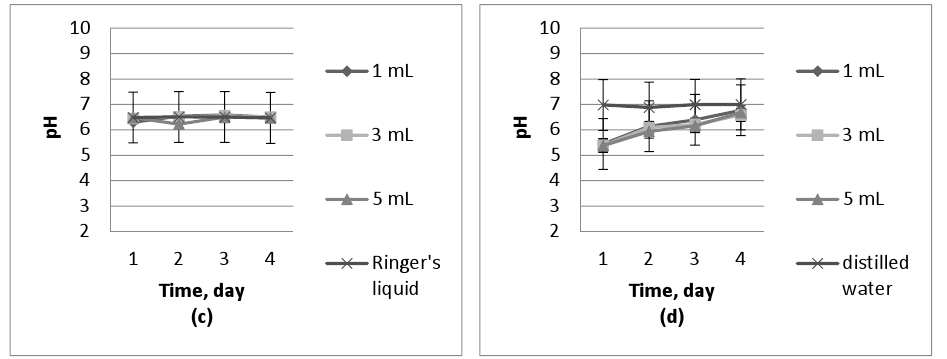
Figure 4. Incubation of chitosan hydrogels in: ( a ) SBF; ( b ) artificial saliva; ( c ) Ringer’s liquid; and ( d ) distilled water.